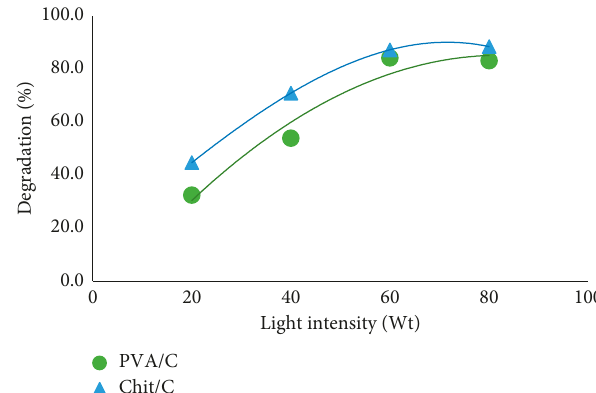
Figure 8: Percentage photodegradation as a function of light intensity. Table 2: Maximum percentage photodegradation (%) of the CR dye by the prepared films with various parameters. The